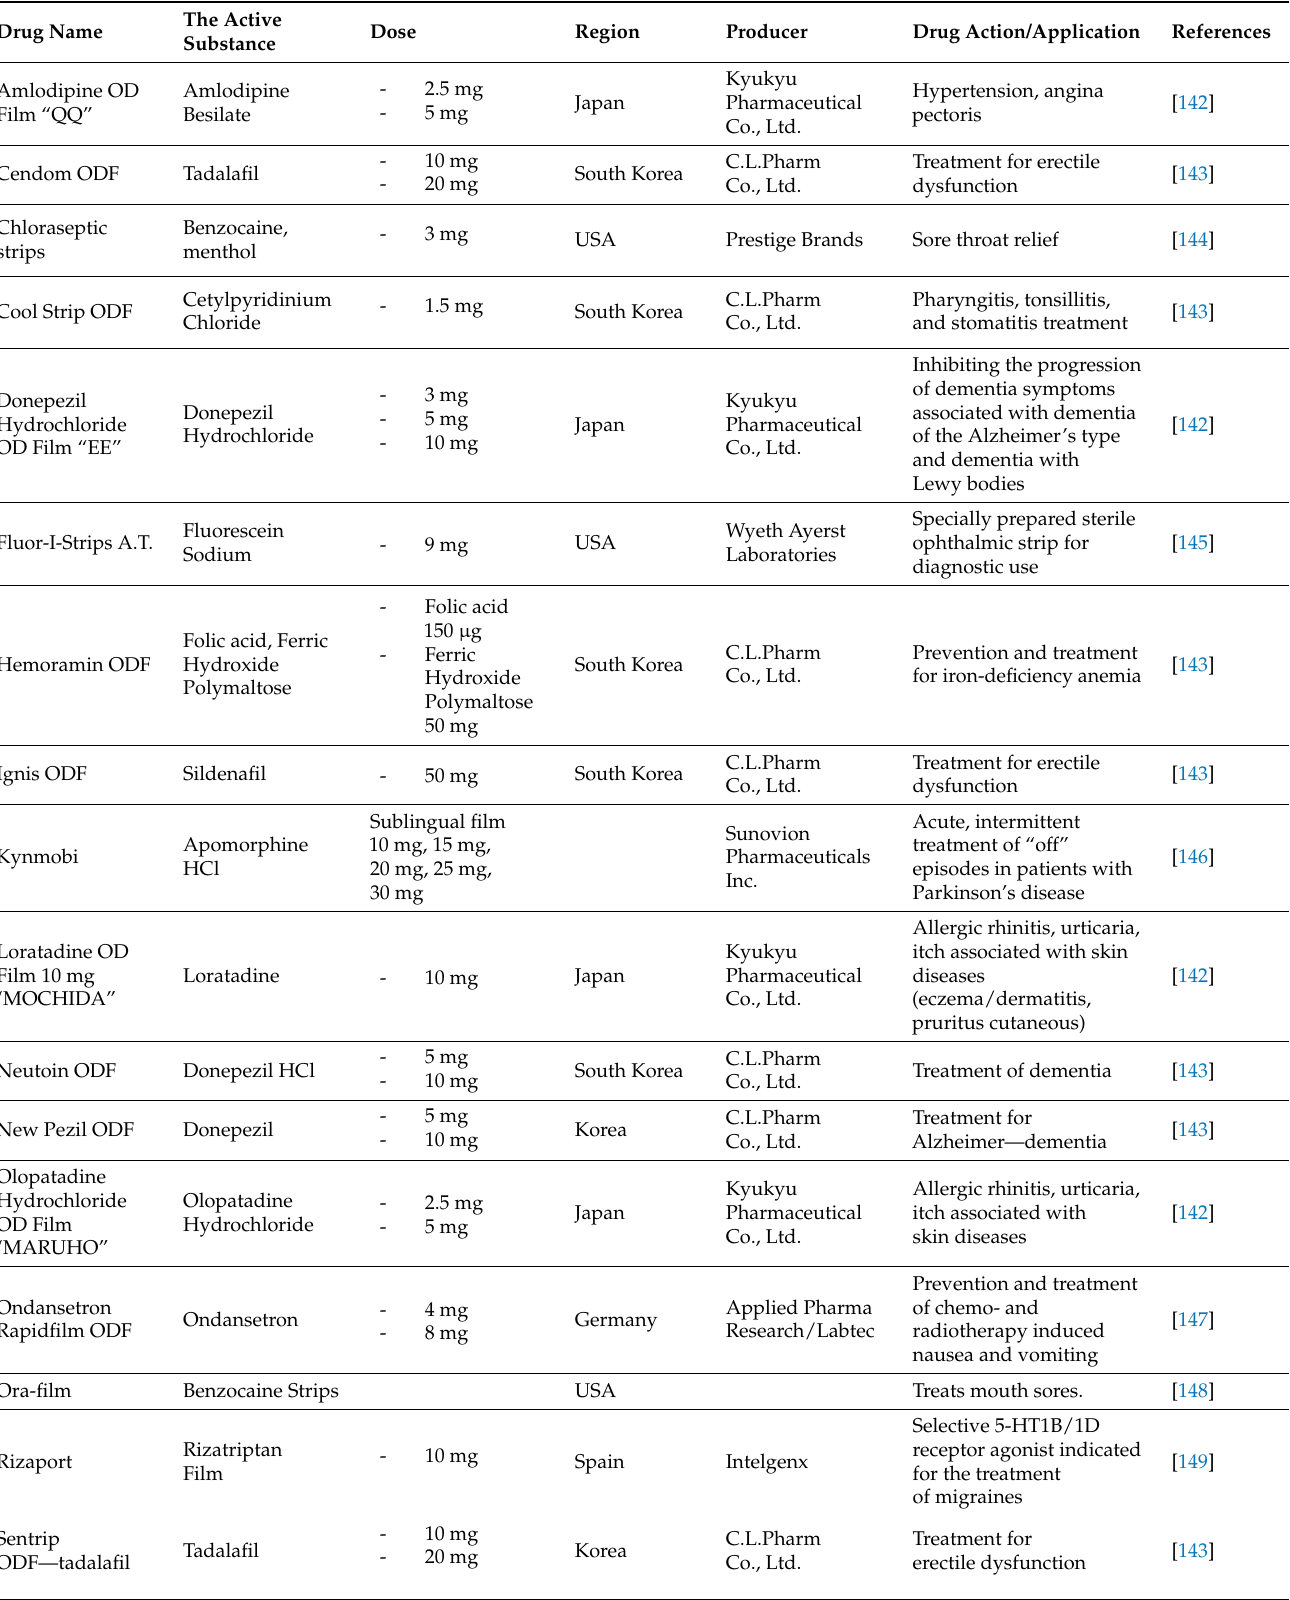
Table 2. Examples of prescription ad OTC ODF